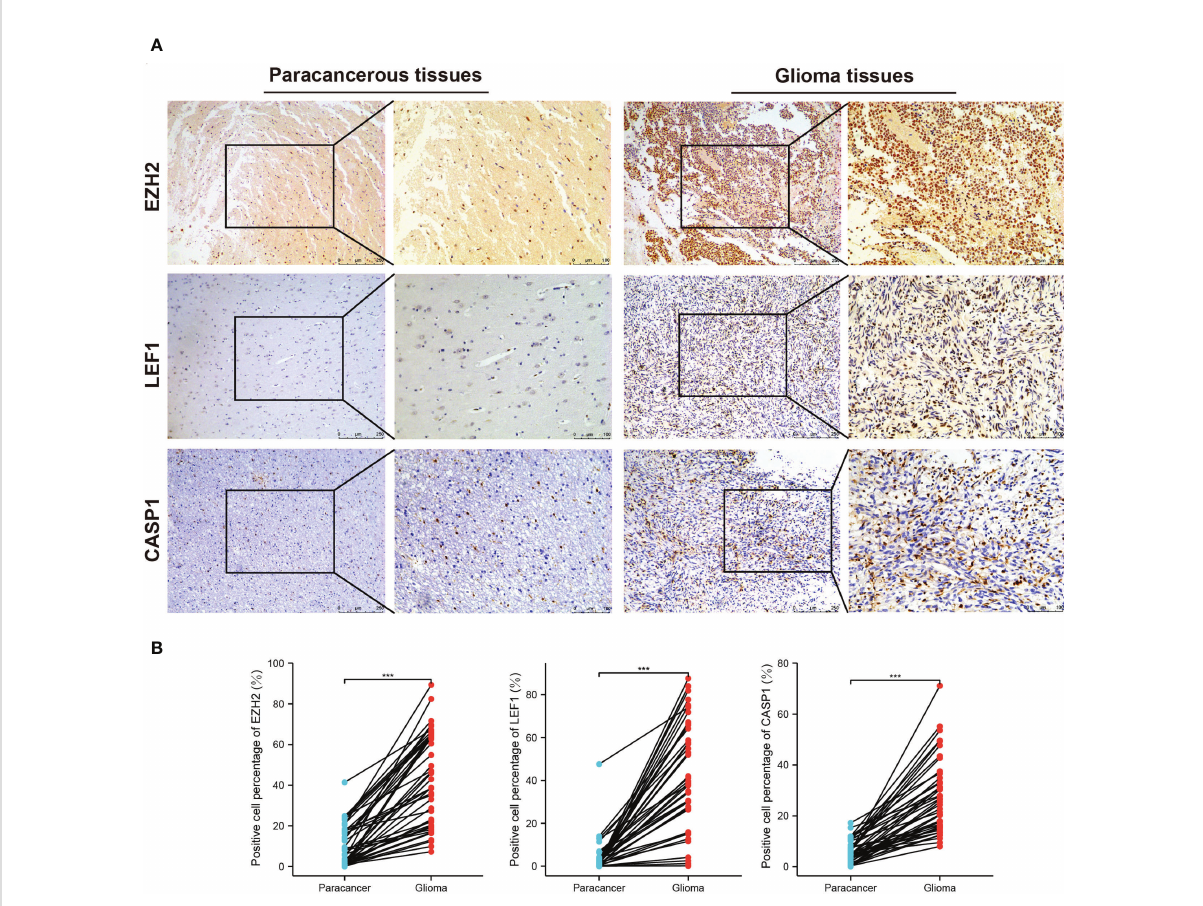
FIGURE 6 IHC staining for EZH2, LEF1, and CASP1 in the third cohort. (A) Representative images of IHC staining in glioma and matched paracancerous samples. The brown color indicates positive staining. (B) Elevated EZH2, LEF1, and CASP1 expression levels in 43 glioma tissues. (*** p <